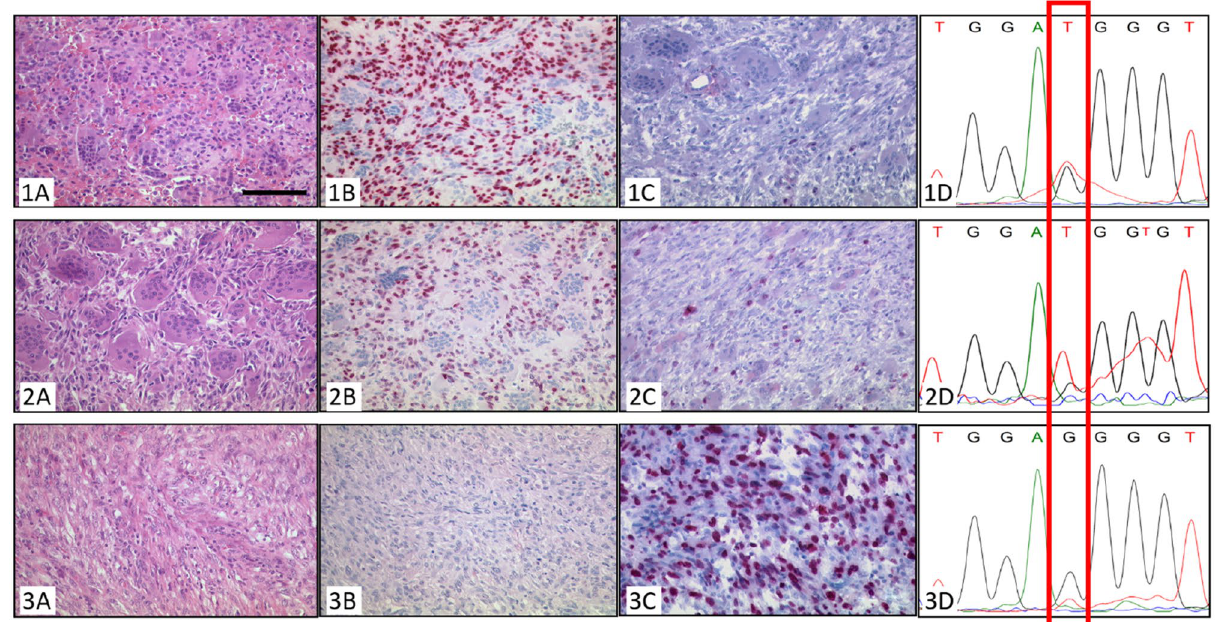
Figure 3. Morphology of Case 3. (1) Biopsy. (2) Resection specimen. (3) Sarcoma. Typical GCTB with osteoclastic giant cells and intermingled mononuclear cells in the biopsy (1A) and the resection specimen (2A) as well as neoplastic mononuclear cells with positive H3F3A G34W staining in the nuclei (1B,2B) (bar = 100 µm). Staining for Ki-67 shows about 1% of positive cells (1C,2C) . Sanger-Sequencing for H3F3A G34W shows the mutation specific thymine in tissue of the biopsy (1D) as well as the resection specimen (2D) . The sarcoma showed spindle to pleomorphic tumor cells and extensive necrosis (3A) and a high Ki-67 index (3C) , however it did not stain positive for H3F3A G34W (3B) . Sanger-sequencing of DNA from microdissected tissue of the H3F3A G34W-negative tumor showed a very weak peak for a mutation-specific thymine (3D) .